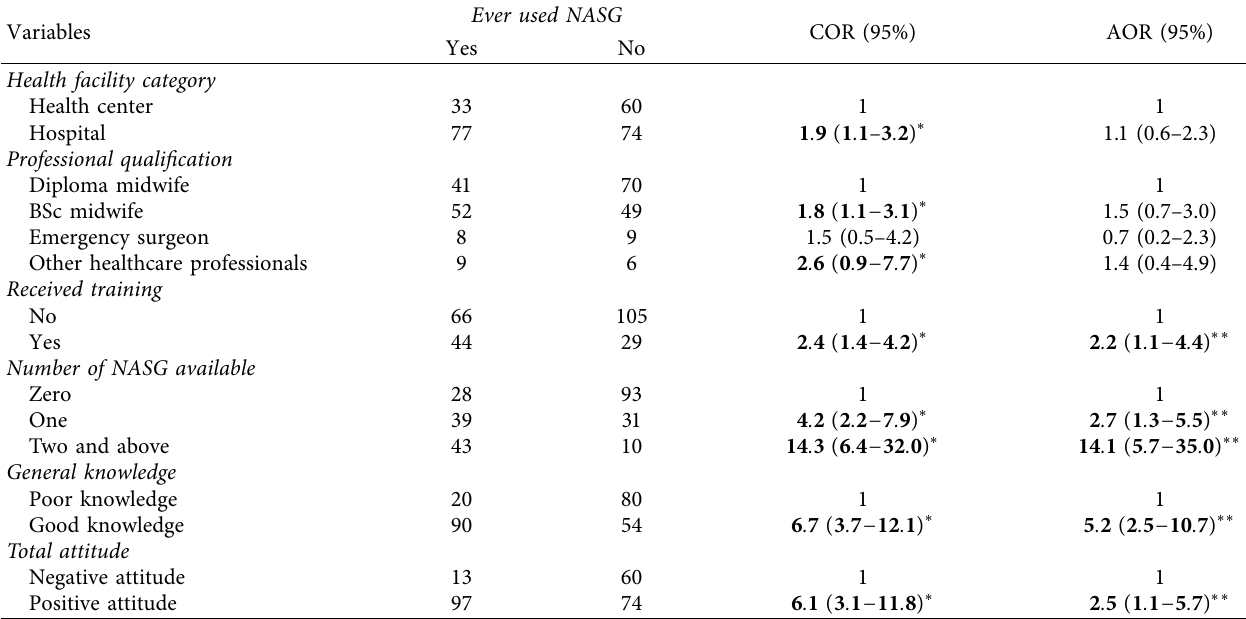
Table 5: Bivariable and multivariate analyses of factors associated with utilization of NASG for management of PPH among maternity ward healthcare professionals in South Wollo Zone health facilities, Northwest Ethiopia,